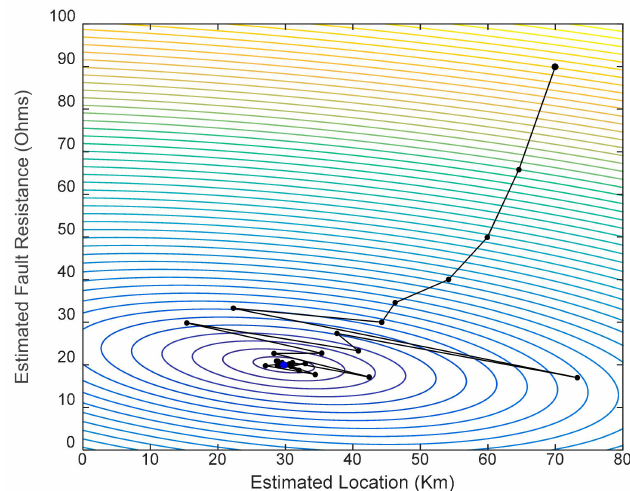
Figure 12. Fault location and resistance: Ellipsoidal.